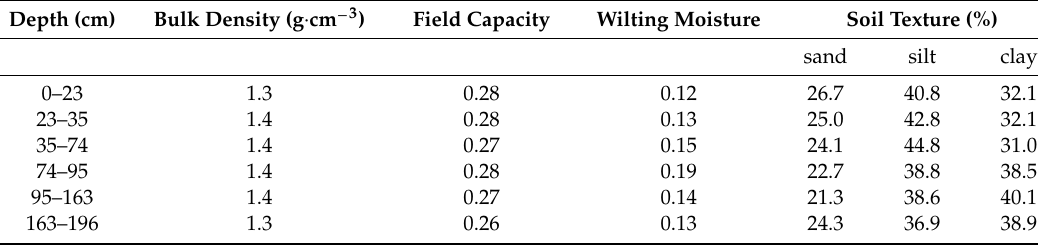
Table 2. Soil physical parameters for the study area, Yangling.